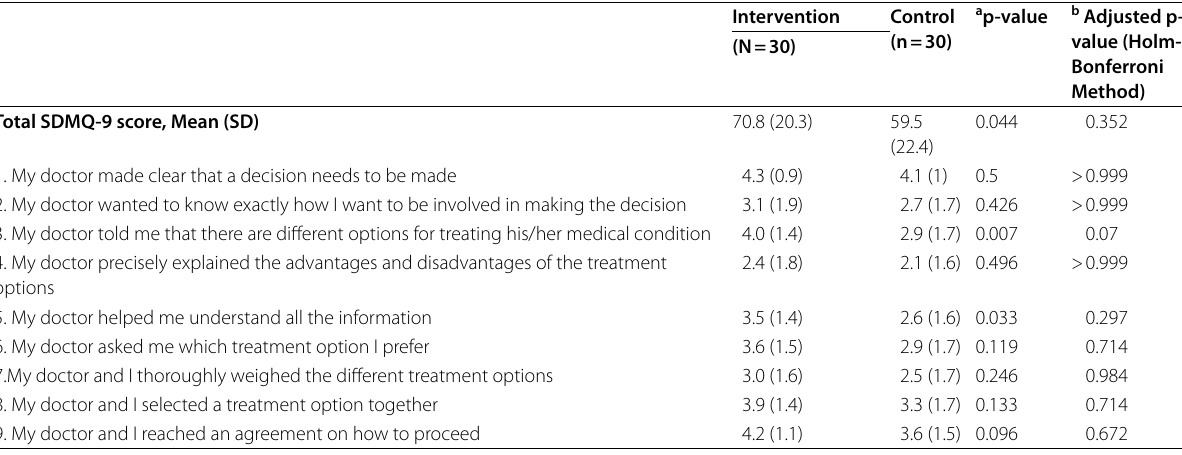
Table 4 Comparison of SDMQ-9 scores among men in the intervention and control groups